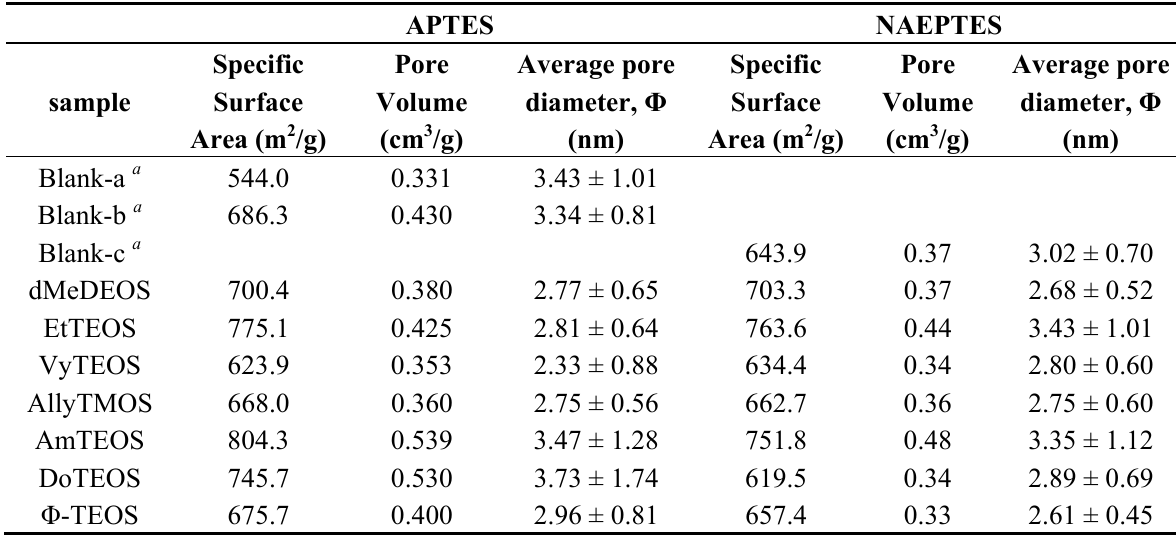
Table 1. Specific Surface areas and average pore widths ( Φ ) of organo-modified silica T( p -COOH)PP species are covalently bonded through the use of xerogels in which H 2 APTES or